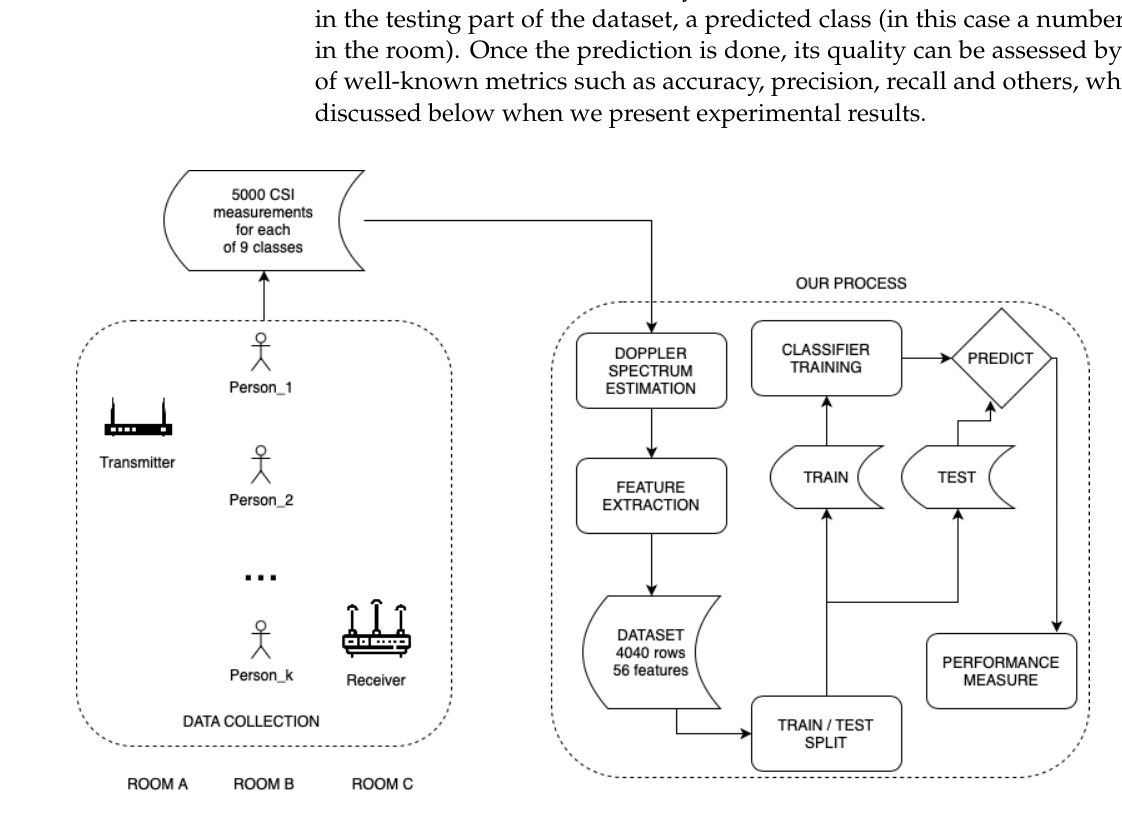
Figure 3. High-level diagram illustrating our